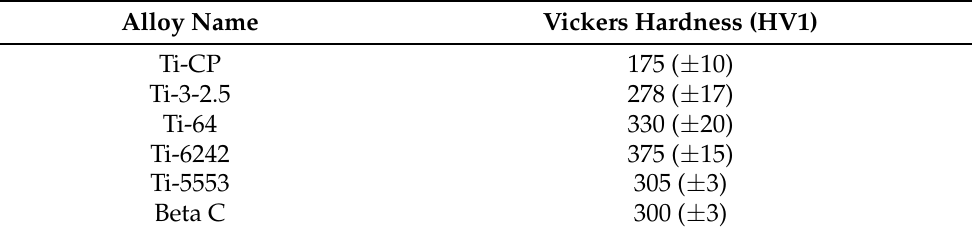
Table 3. Titanium alloys and their corresponding Vickers hardness (indentation load 1 Kg, HV1).